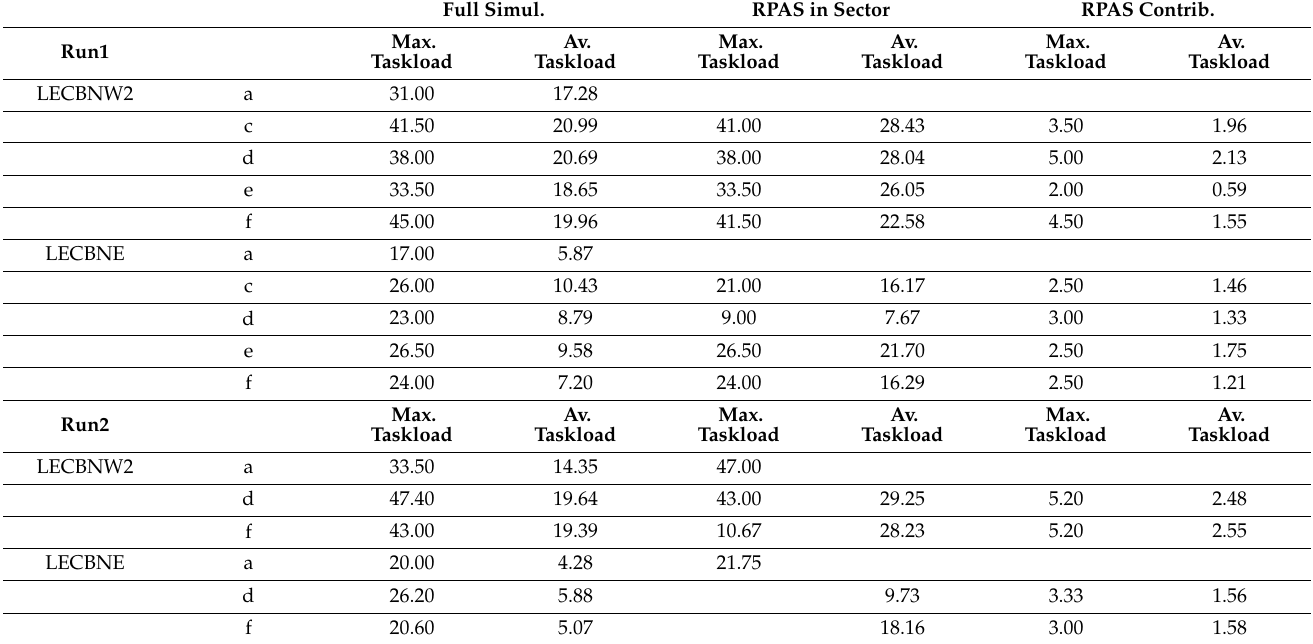
Table 13. CAPAN task load measures associated with the MQ-9 contingency simulations. Full Simul. RPAS in Sector RPAS Contrib.